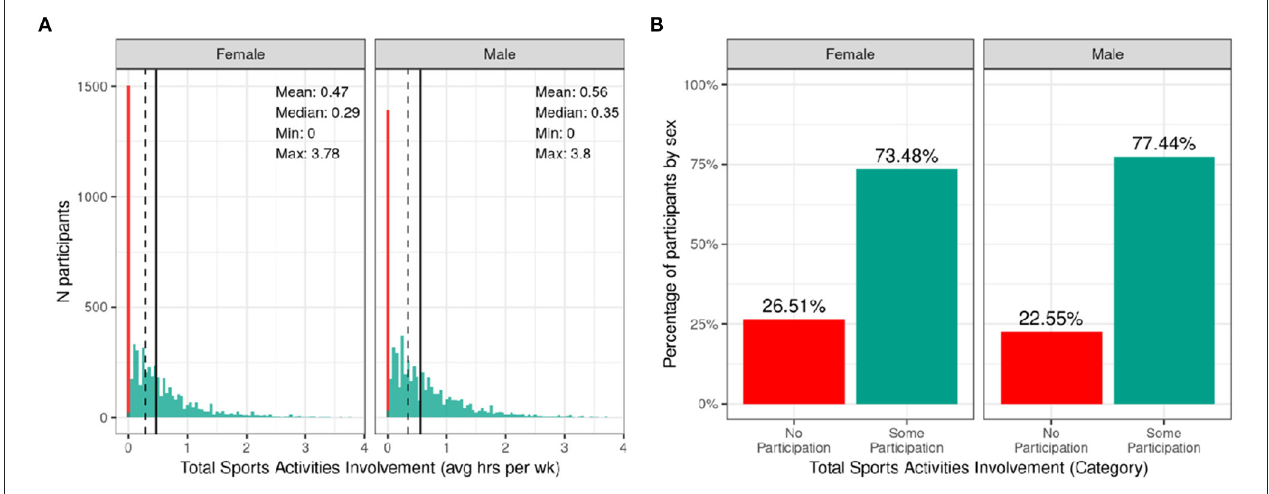
FIGURE 8 | Distribution of time spent participating in sports across the ABCD sample. (A) Continuous distribution of the average hours per week each participant (stratified by sex assigned at birth) participated in sports (total across all sports endorsed) in the past year as indicated by the Sports Activities Involvement (SAI) questionnaire. (B) Percentage of participants (stratified by sex assigned at birth) who indicated no participation in sports (red) and some participation in sports